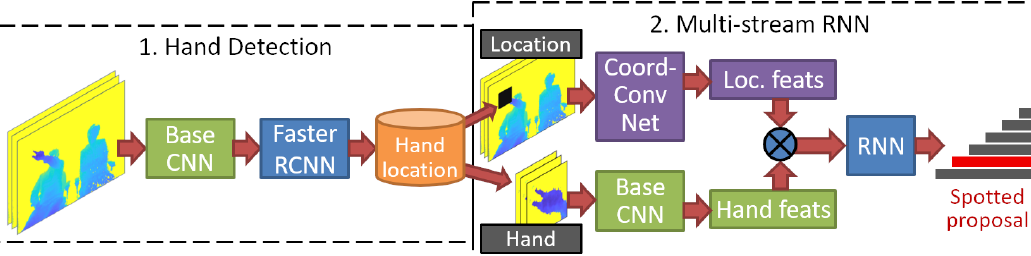
Figure 2. An overview of our approach. The input of the first module is a raw frame processed with faster R-CNN [30] to detect the hand that performs a finger gesture. In the first branch of the second module (highlighted in purple), hand-location features are extracted by a CoordConv network [29], which handles the input frame overlaid by a black mask on the detected hand region. In the second branch, the hand region is cropped, and features are extracted using the base CNN employed in the first module (highlighted in green). The combination of both features is feed to an recurrent neural network (RNN) architecture [26] trained to define the video segments that may contain a finger gesture. Finally, RNN outputs confidence scores of multiple candidates that finish at the current